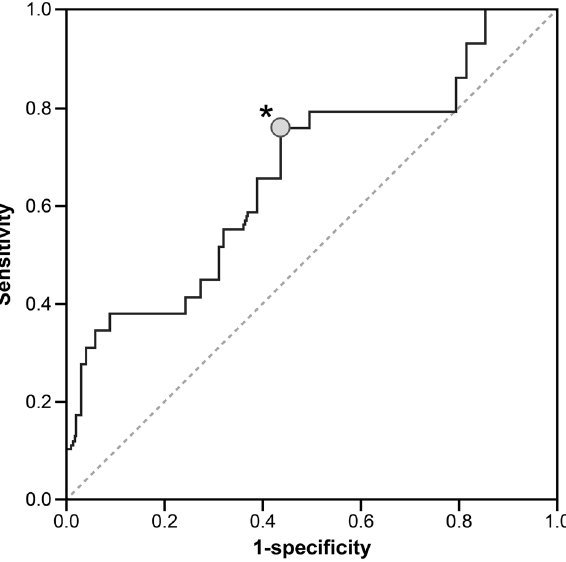
Figure 6. ROC and COV of GFO to be mHHS ≧ 80. The cutoff value of mHHS ≥ 80 was calculated using the ROC. ⋆ was the cut off value. The sensitivity and 1-specificity were 0.759, and 0.437, respectively. ROC receiver